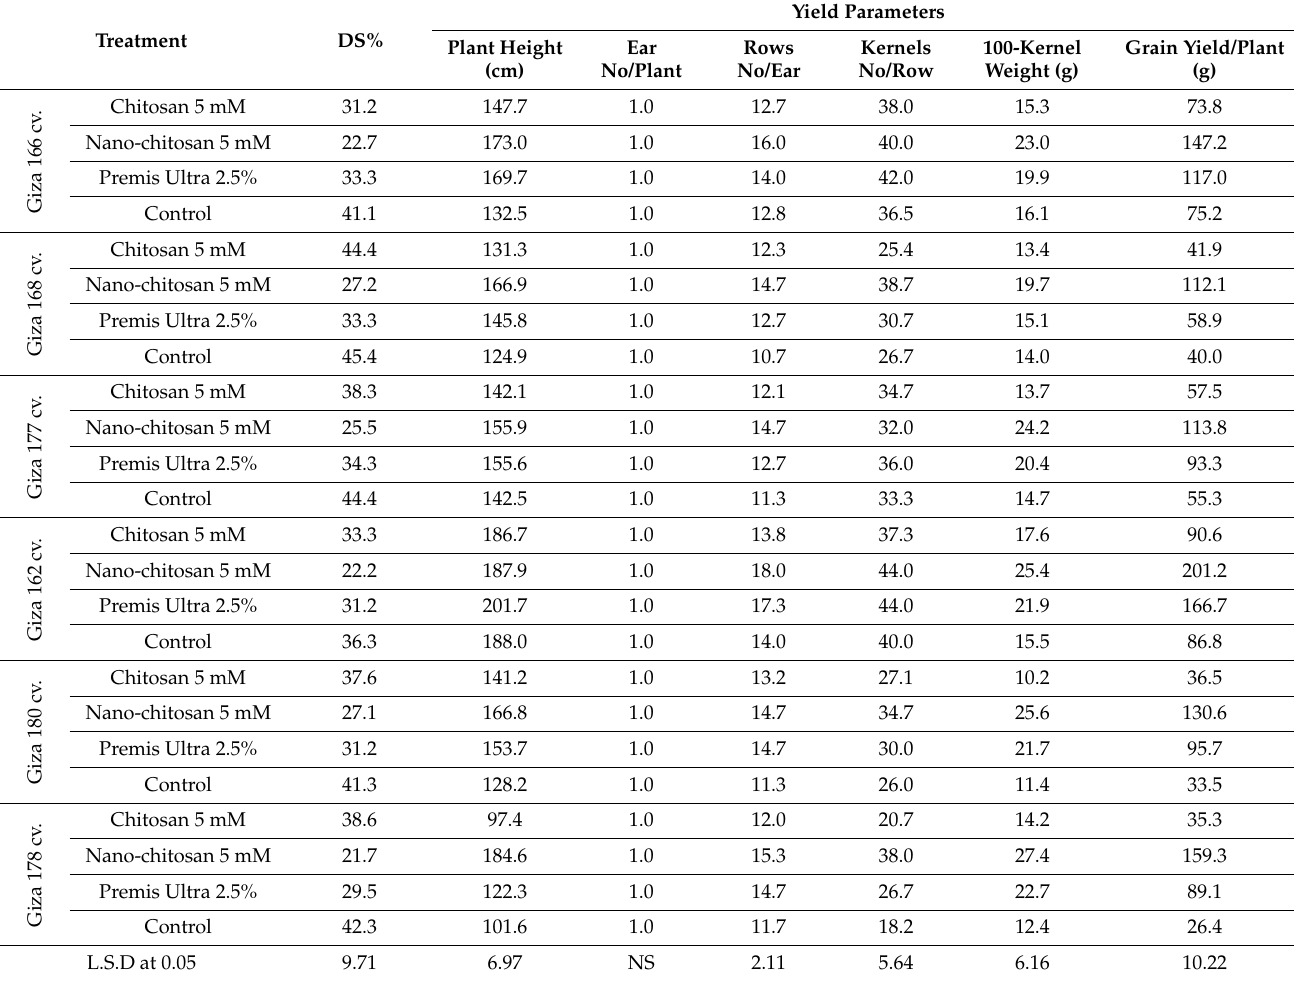
Table 2. Effect of chitosan, nano-chitosan, and Premis Ultra 2.5% fungicide on disease severity and crop parameters of some corn cultivars under natural infection with late wilt